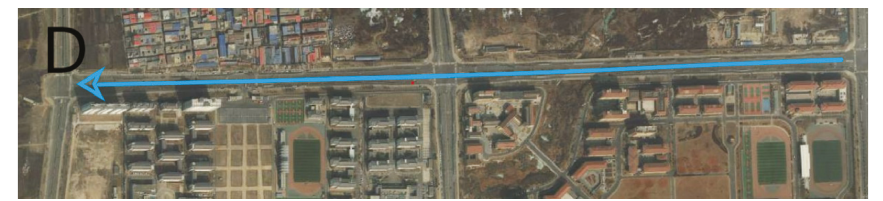
Figure 6: The original measurement trajectory under route D